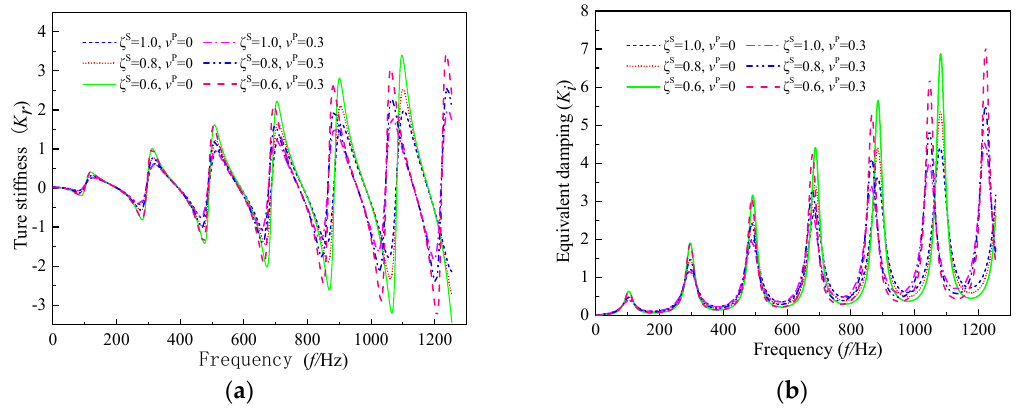
Figure 8. The effect of the degree to which soil is weakened due to a construction disturbance on the longitudinal impedance of the pile shaft: ( a ) true stiffness; ( b ) equivalent damping. Appl. Sci. 2020 , 10 , x FOR PEER REVIEW